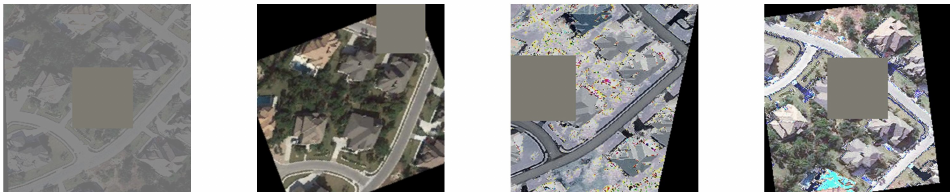
Figure 3. Multiple strong augmentation methods are randomly applied to remote sensing